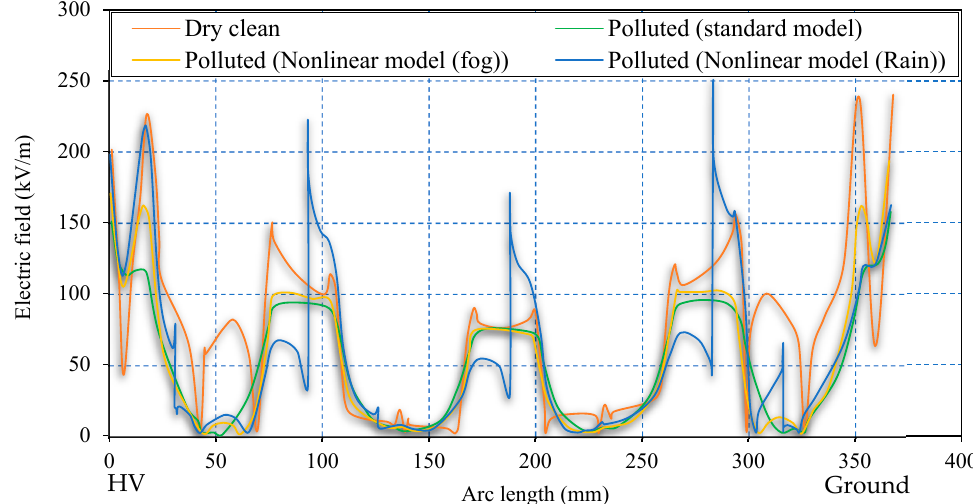
Figure 16. Comparison of tangential electric field distribution for insulator under dry–clean and polluted surface conditions (standard model (single conductivity of 0.6 µS/m (green line)), nonlinear model (fog) (orange line), and nonlinear model (rain) (blue line)).